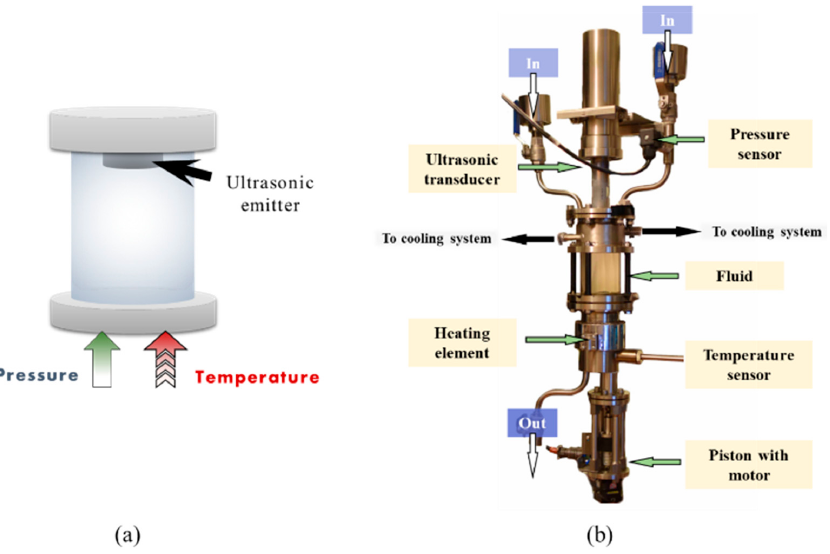
Figure 3. ( a ) A schematic illustration of a reactor component in cavitation testing. ( b ) An experi- mental setup. Table 1. Parameters of reactor